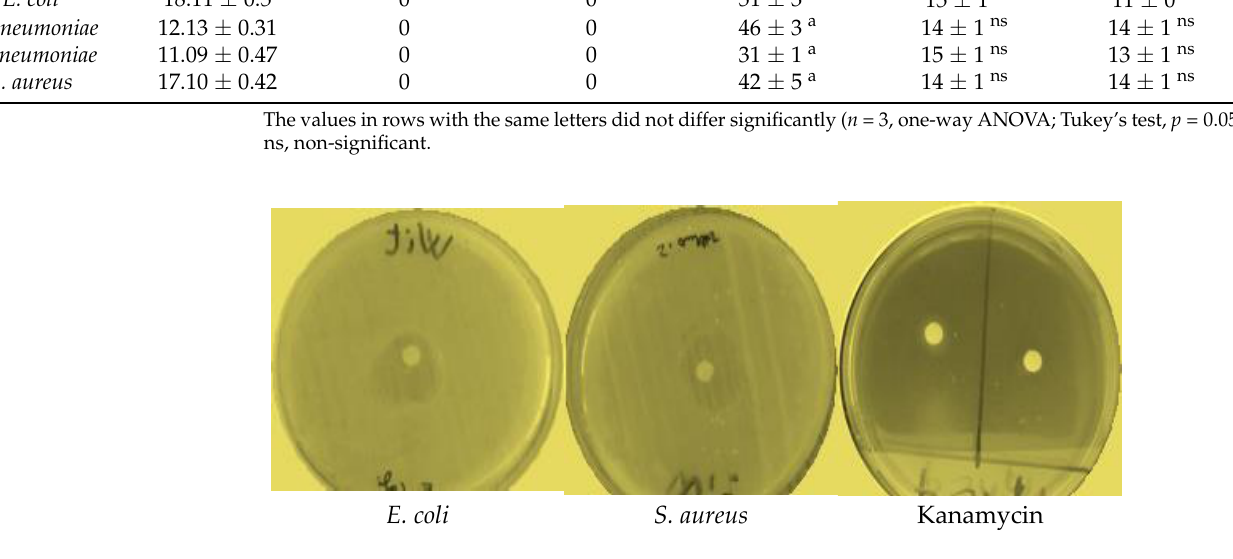
Figure 3. Photographs showing zones of inhibition of EOW with Kanamycin against bacteria. Table 2. Diameters of zones of inhibition and MICs for EOW, Kanamycin, and Oxacillin against strains of bacteria.